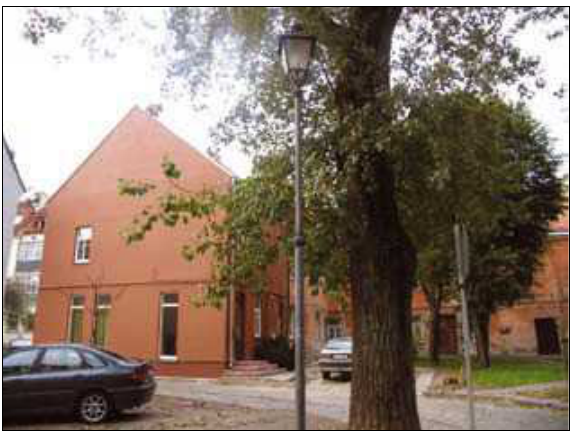
Fig. 4. extension of the block of flats with a shop in Šiau­liai st. a­rch. G. Čaikau­skas, P. Petku­s